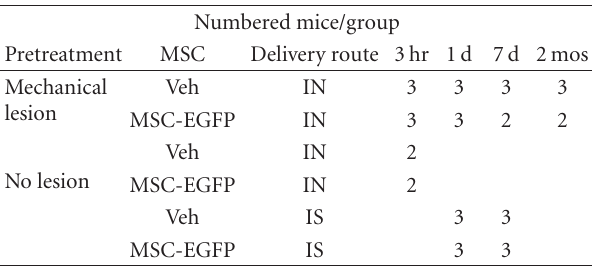
Table 1: Treatment